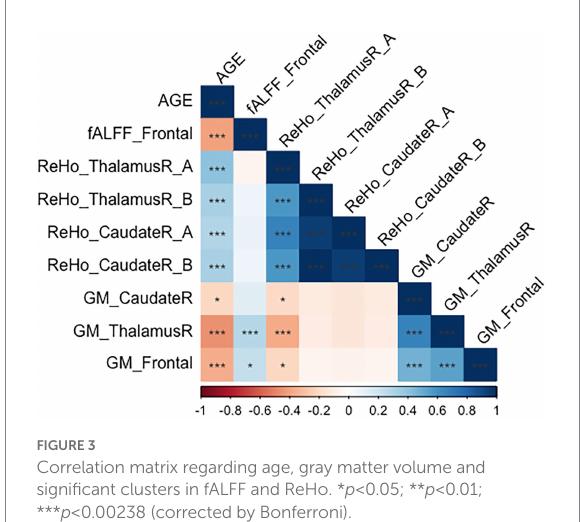
FIGURE 3 Correlation matrix regarding age, gray matter volume and significant clusters in fALFF and ReHo. * p < 0.05; ** p < 0.01; *** p < 0.00238 (corrected by Bonferroni).